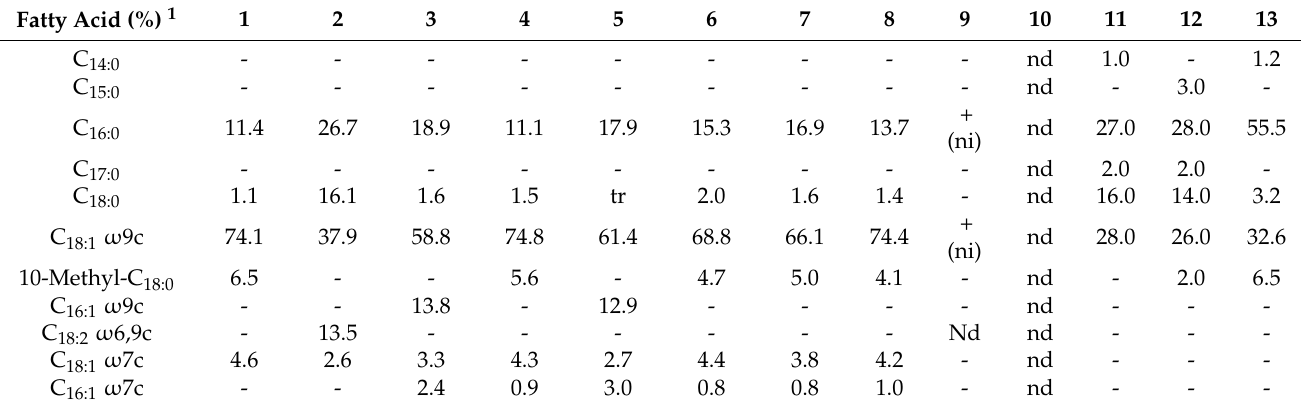
Table 3. Cellular fatty acid composition (percentages) of the 10 strains analyzed in this study and closely related type strains. Strains: 1, c8Ua_144; 2, c8Ua_172; 3, c8Ua_174; 4, c8Ua_181; 5, c9Ua_112; 6, c19Ua_109; 7, c19Ua_121; 8, c21Ua_68; 9, C. afermentans CIP 103499 [32]; 10, C. tuscaniense CCUG 51321 [33]; 11, C. jeikeium ATCC 43734 [34]; 12, C. tuberculostearicum DSM 44922 [35];